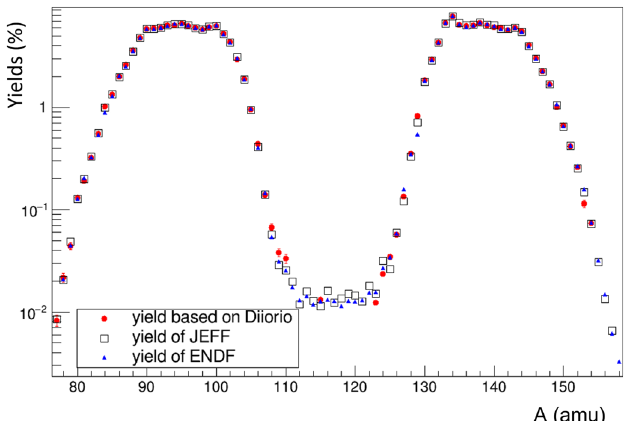
Fig. 8. Chosen evaluation of 235 U( n th , f ) mass yields according to the maximum Shannon entropy in comparison to the JEFF-3.1 and the ENDF/B-VII.1 libraries. A very good agreement is observed all over the mass range for